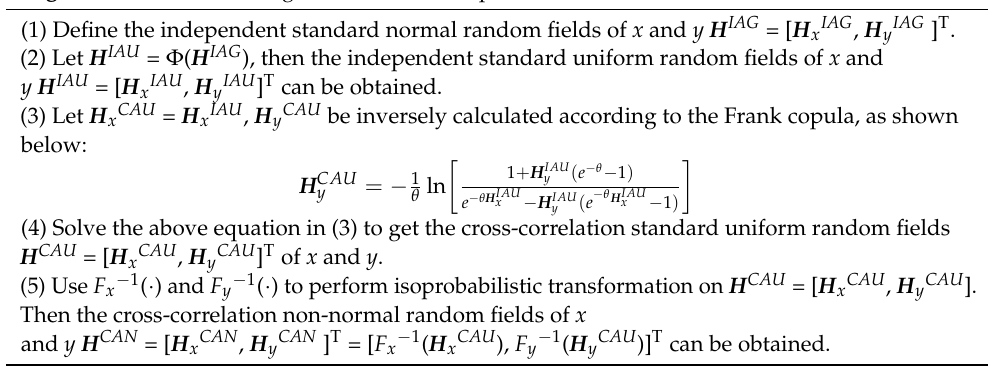
Algorithm 4 Simulation algorithm of Frank copula-based CCRF